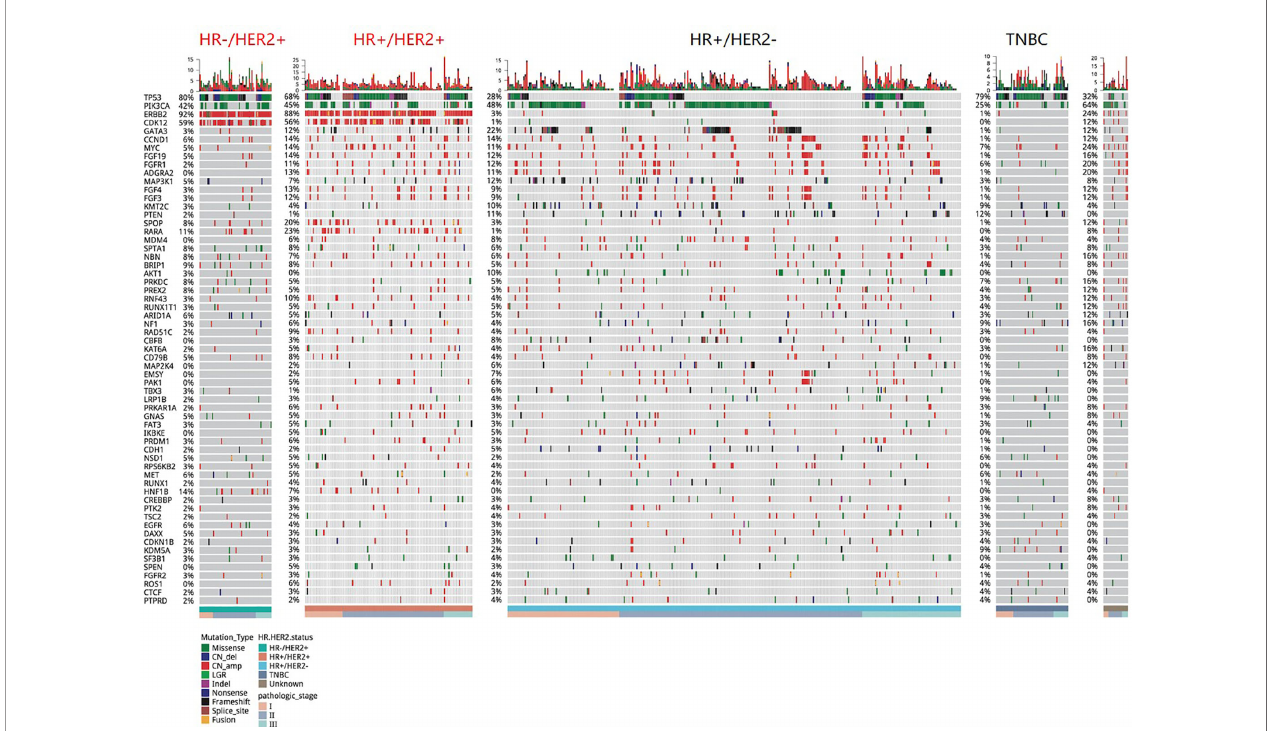
FIGURE 1 | A summary of the genomic characteristics of 589 Chinese breast cancer patients. Oncoprint showed genetic changes with an incidence of more than 2%. According to the HR and HER2 status, the tumor samples were strati fi ed into: HR+/HER2 (n = 321), HR+/HER2+ (n = 111), HR − /HER2+ (n = 64), triple-negative (n = 68), and unknown (n = 25). The sidebar summarizes the percentage of tumors with mutations in each gene. Different colors indicate different types of mutations. Clinicopathological features were annotated at the bottom. Indel, insertion or deletion variations; CN_amp, copy number ampli fi cation; CN_del, copy number